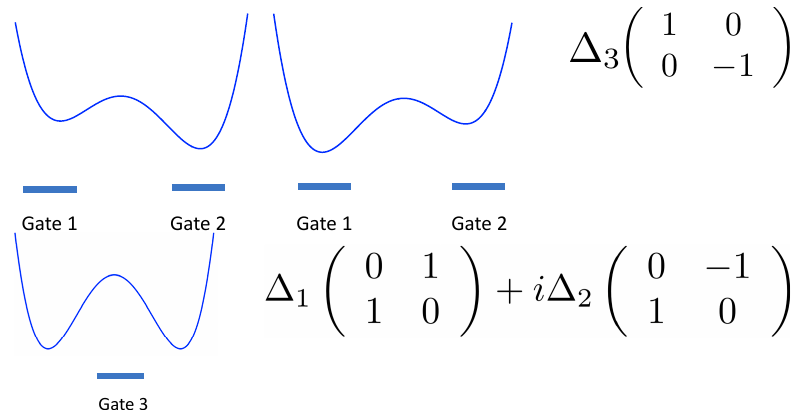
Figure 4: Slow noise produced by the back gate in double QD. Top: "diagonal" noise describing fluctuations of the level positions; Bottom: U ( 1 ) fluctuations of the barrier. Three 2 × 2 Pauli matrices constitute the basis for the fundamental representation of the SU ( 2 )